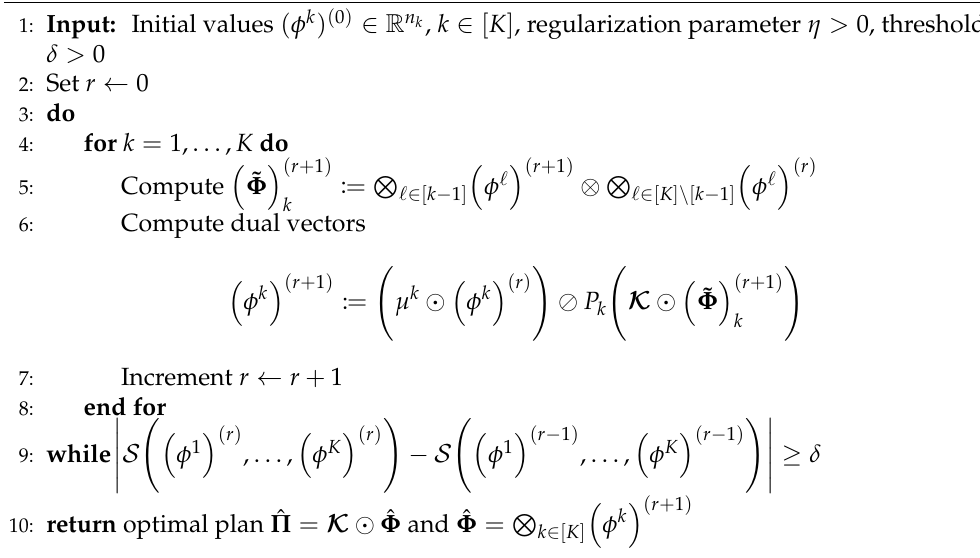
Algorithm 1 Sinkhorn iterations for the MOT η